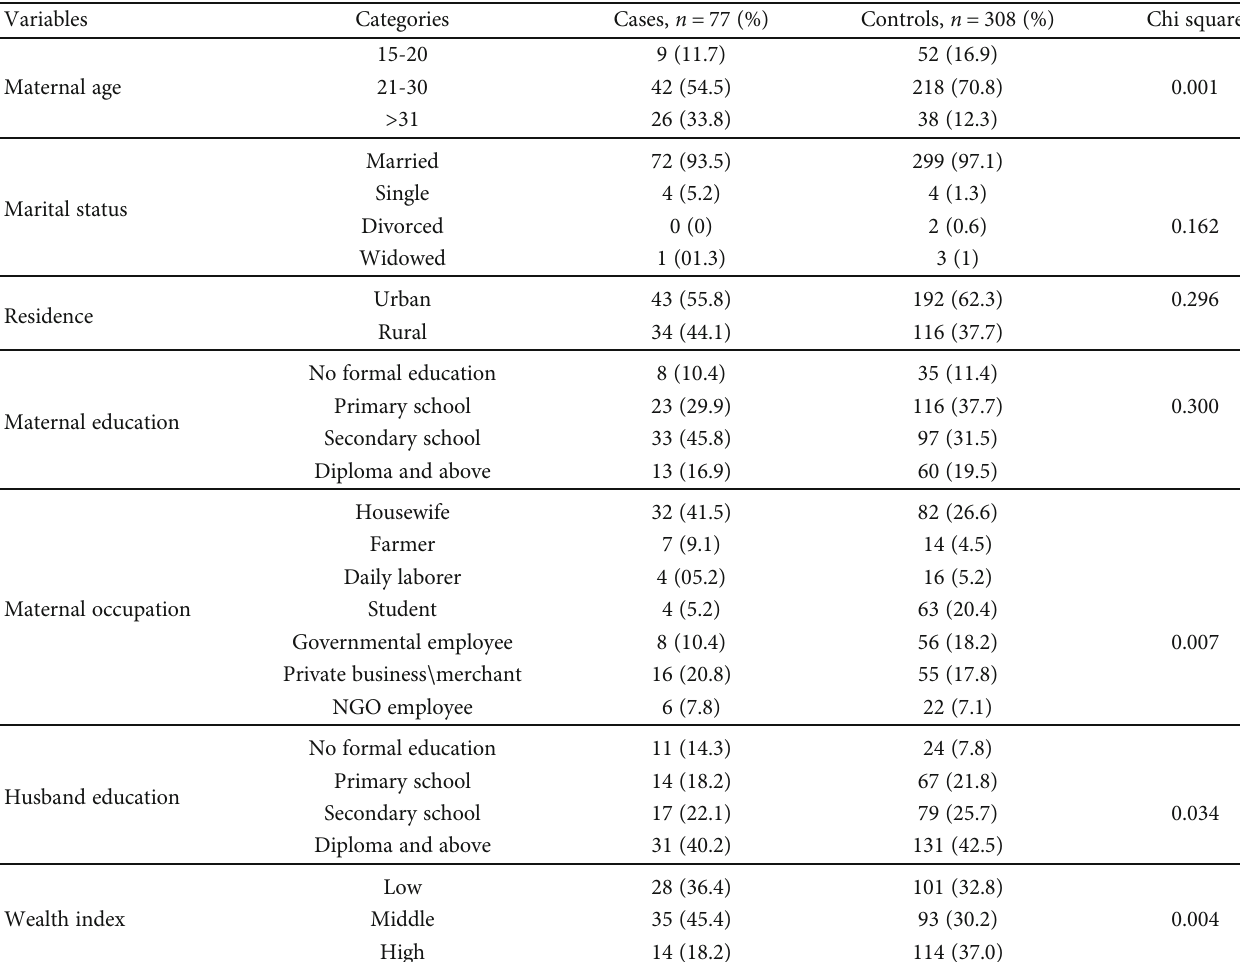
Table 1: Maternal sociodemographic and wealth factor for neonatal sepsis among neonates at SCGH and WSUTRH, Wolaita Sodo town,